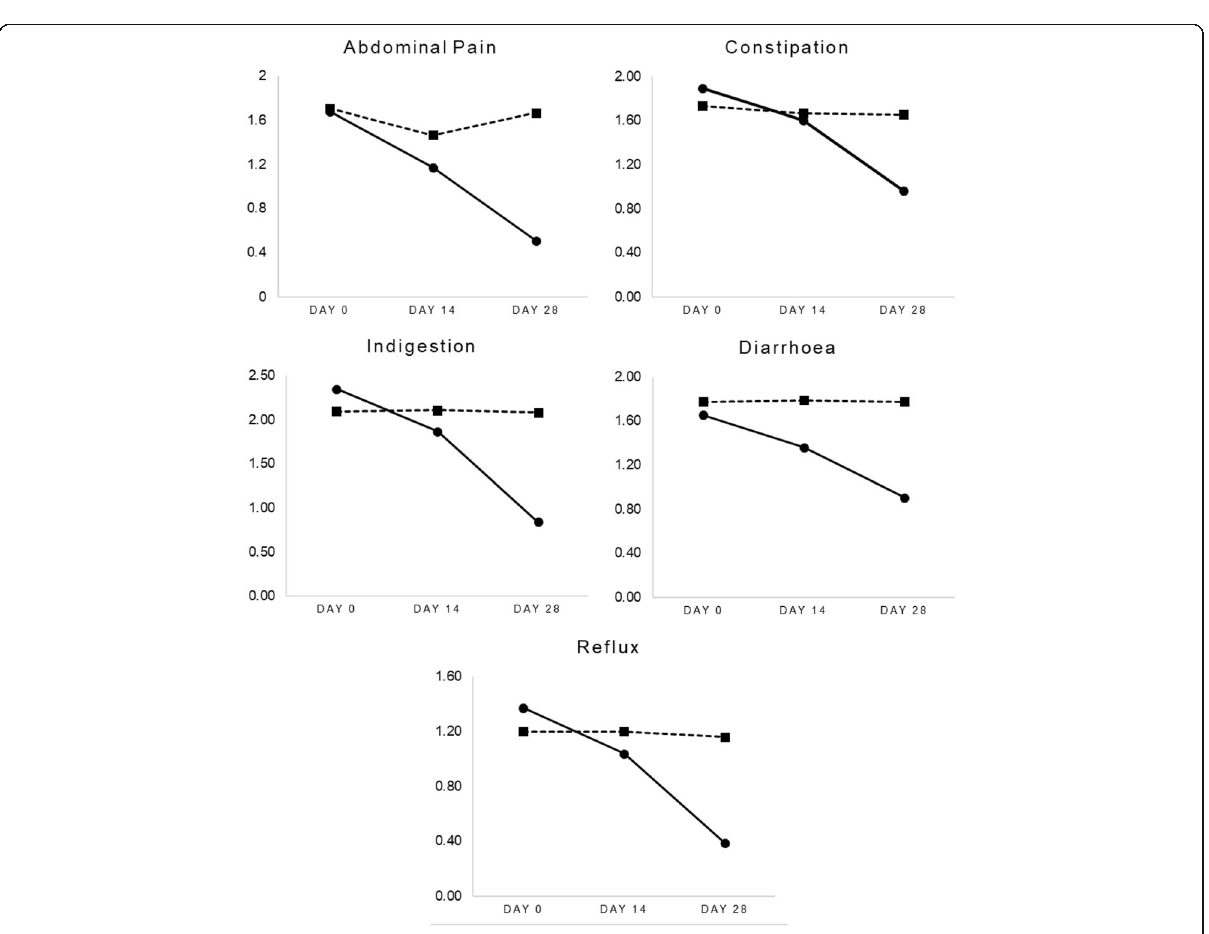
Fig. 2 GSRS domain ratings over